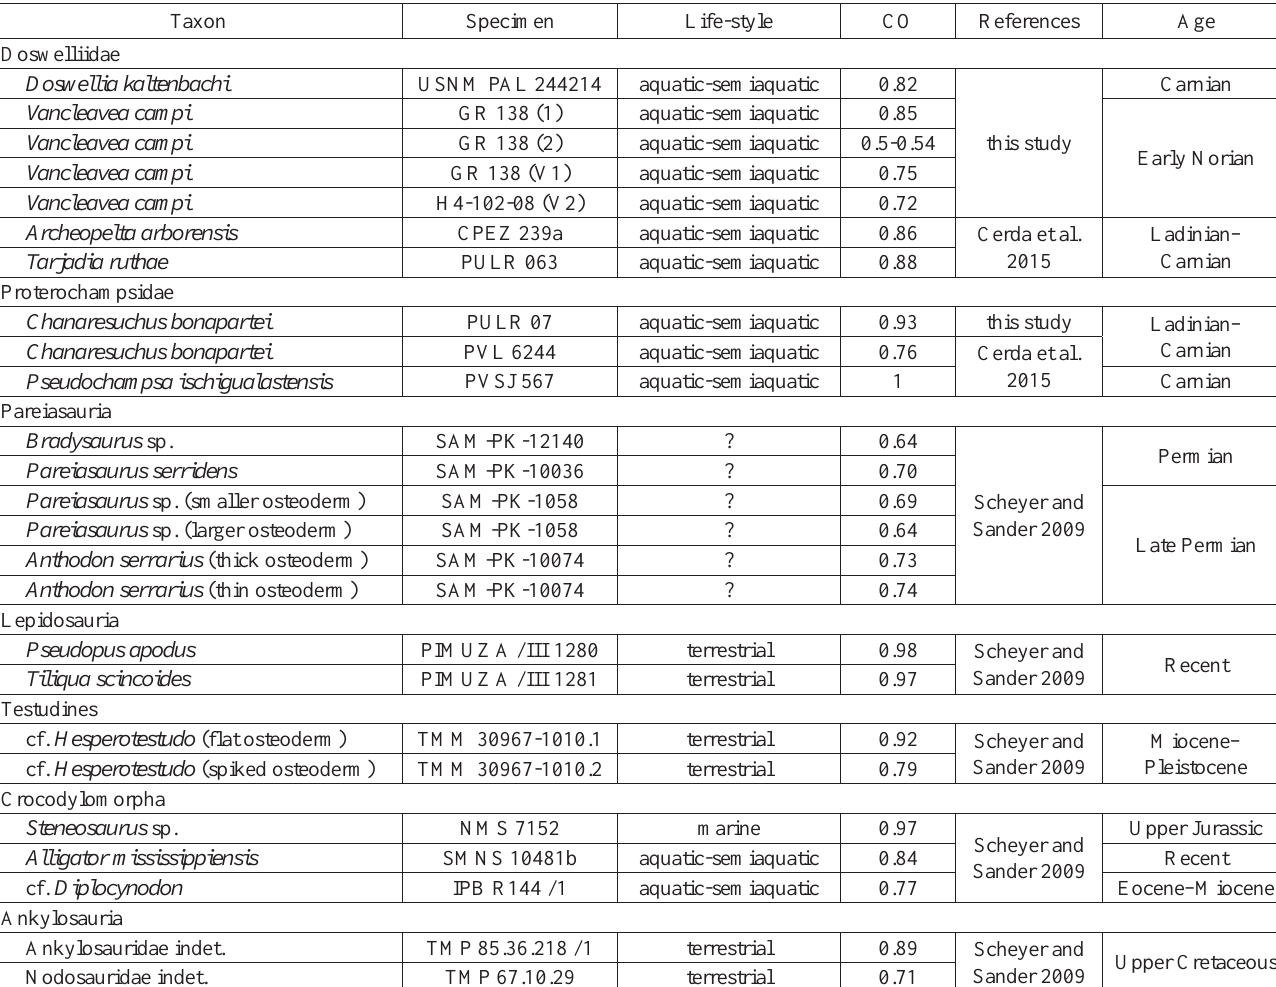
Table 2. Comparison of observed compactness (CO) and life-styles among Archosauriformes and several Reptilia